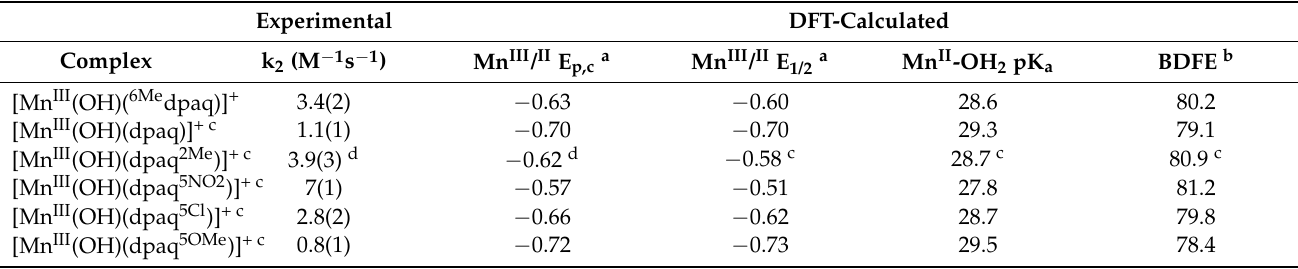
Table 2. Second-Order Rate Constants ( k 2 ) for TEMPOH Oxidation by Mn III -hydroxo Complexes, Experimental E p,c Values, and DFT-Calculated Thermodynamic Parameters. Experimental DFT-Calculated